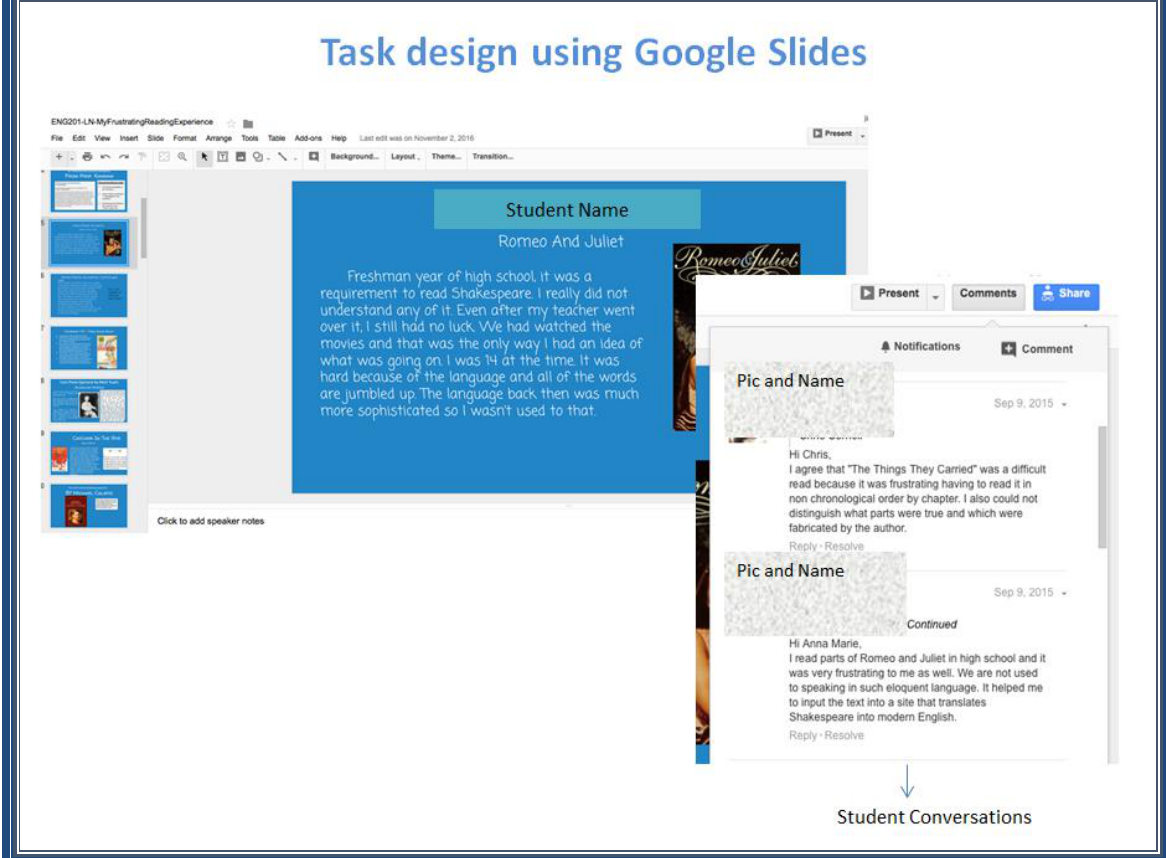
Fig 1 – Task design using Google